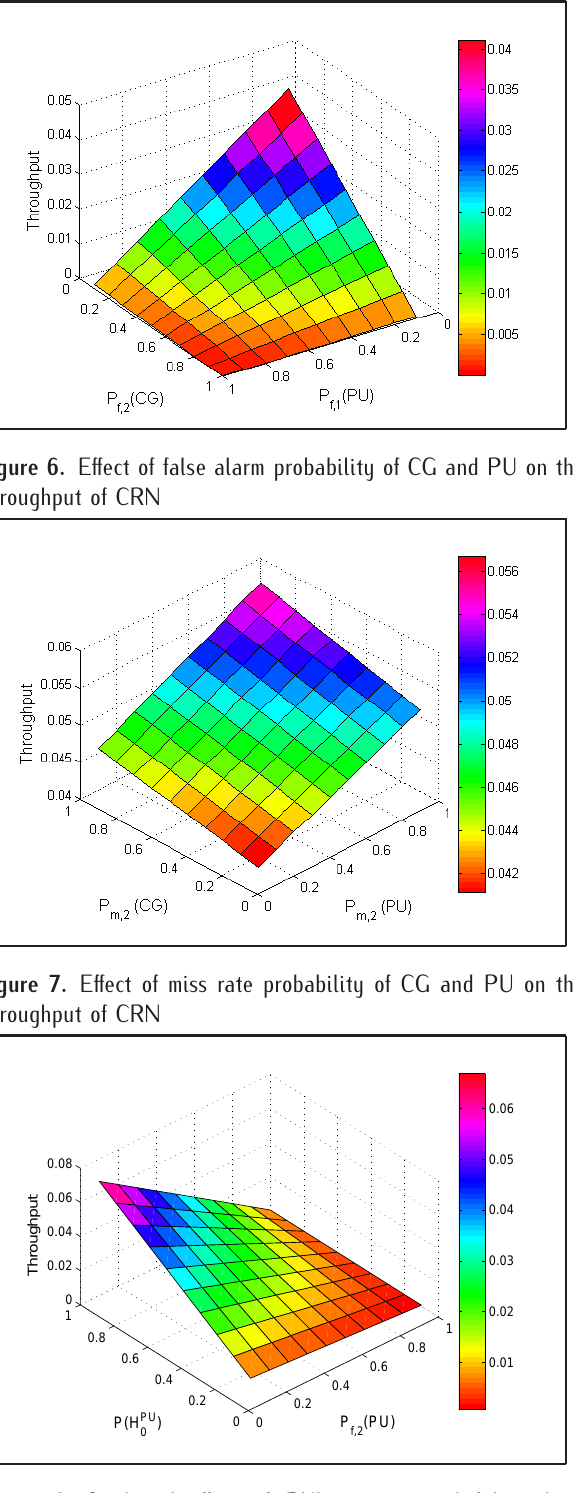
Figure 8. Combined effect of PU’s activity and false alarm probability of CRN at PU on the Throughput of CRN ) with highest throughput is achieved at highest P ( H PU 0 no visible e ff ect of P PU on f , 1